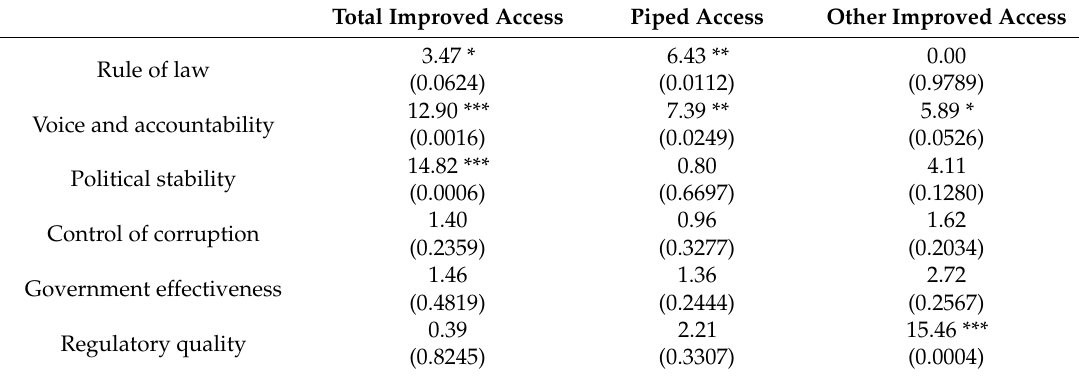
Table A4. Results of Wald test for middle-high income countries.